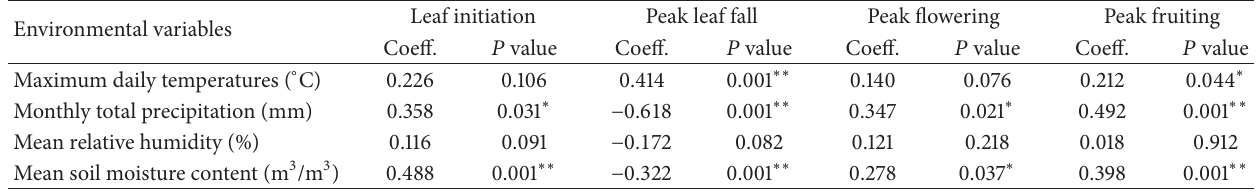
Table 2: Correlation of S. senegal phenological events with climatic